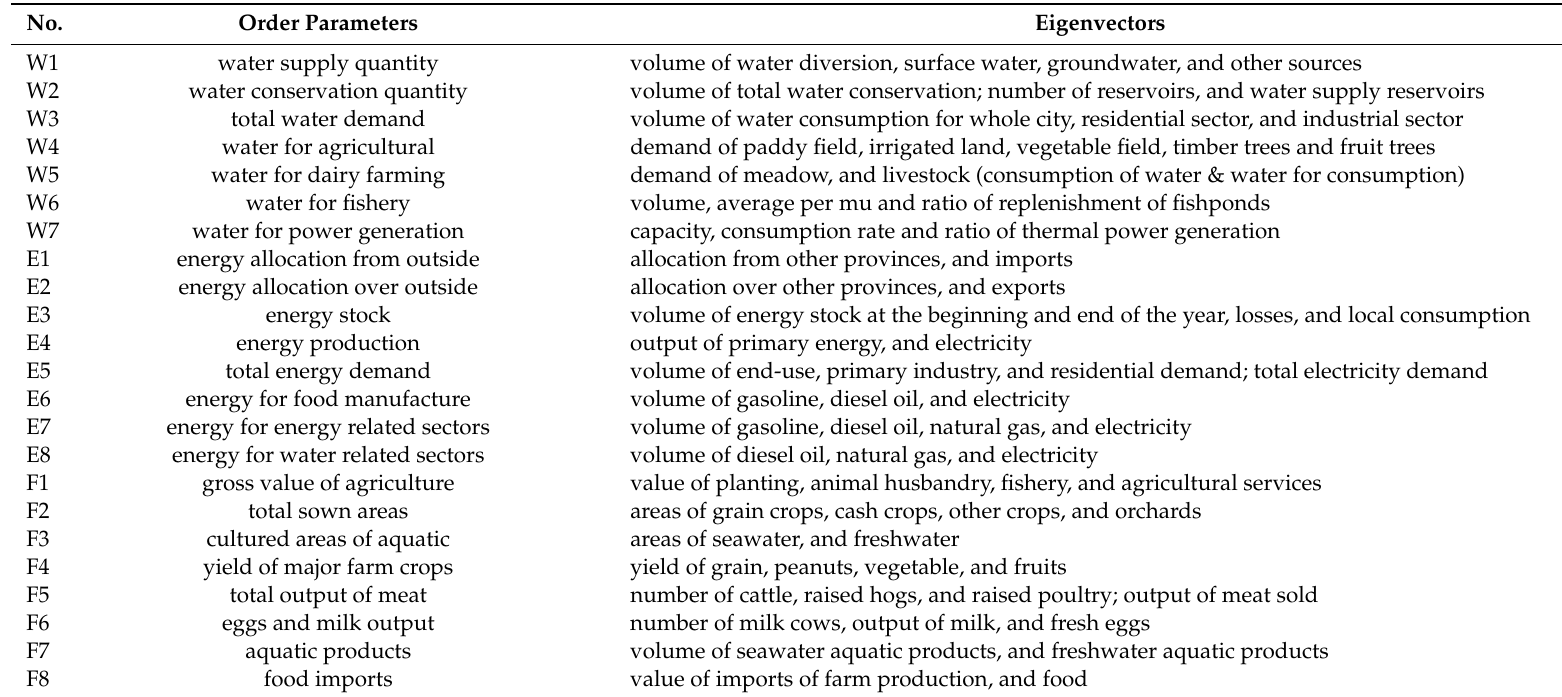
Table 3. The eigenvectors under WEF-Nexus order